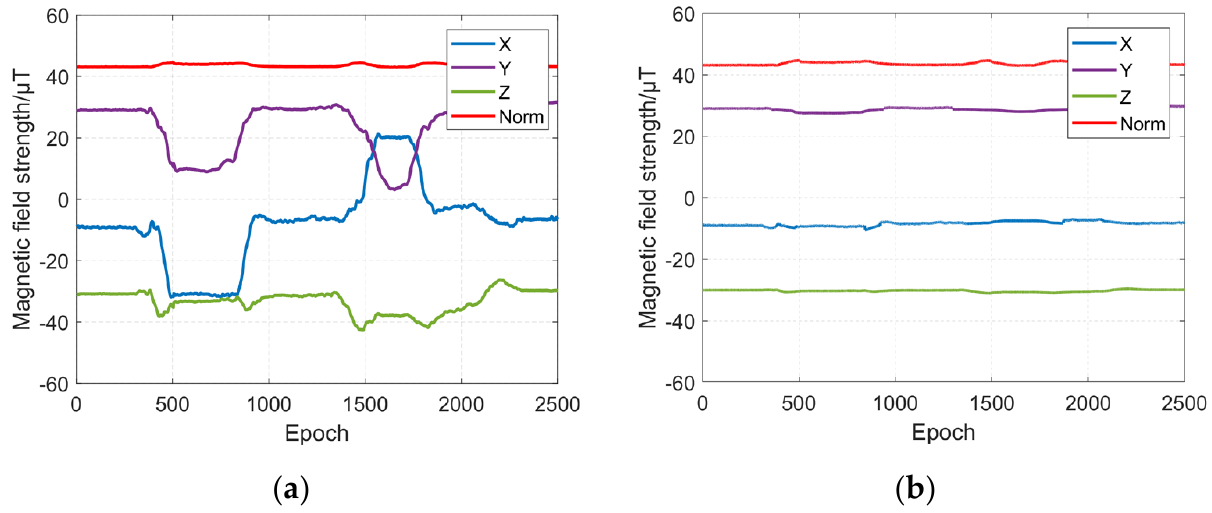
Figure 4. Magnetic field strength before ( a ) and after ( b ) the change.